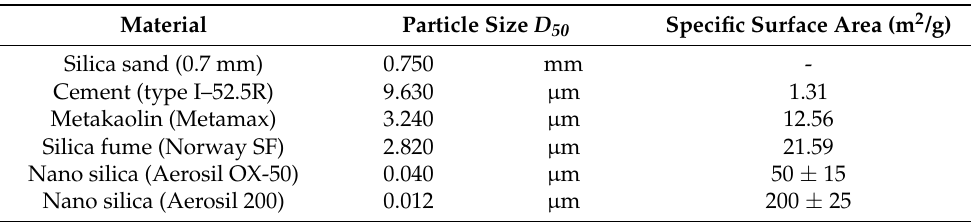
Table 1. D 50 particle size and specific surface of raw materials.